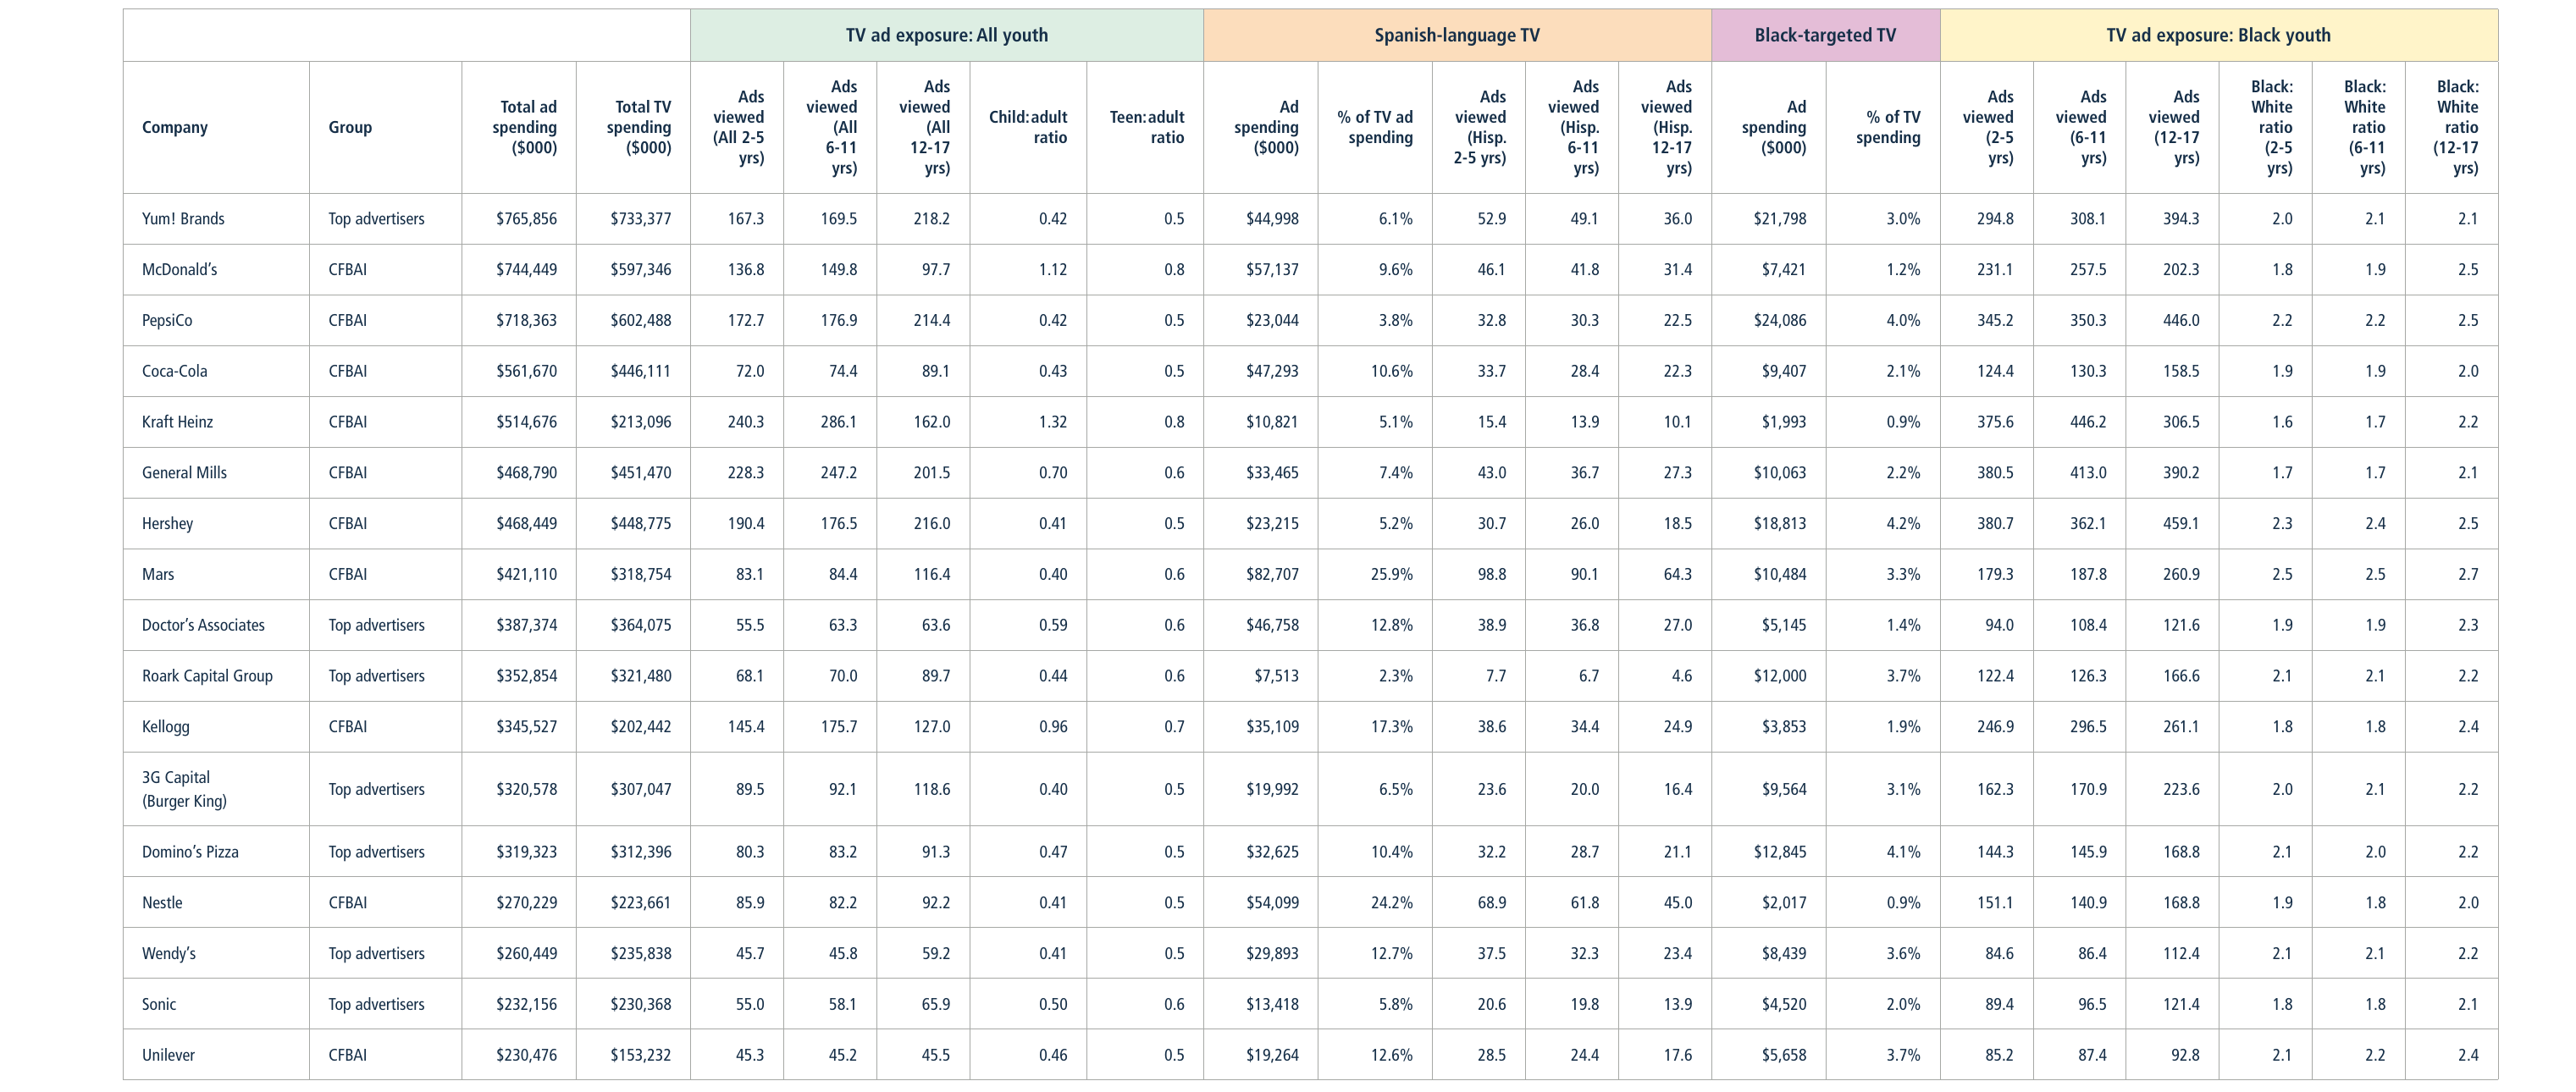
TABLE 1. TARGETED ADVERTISING BY